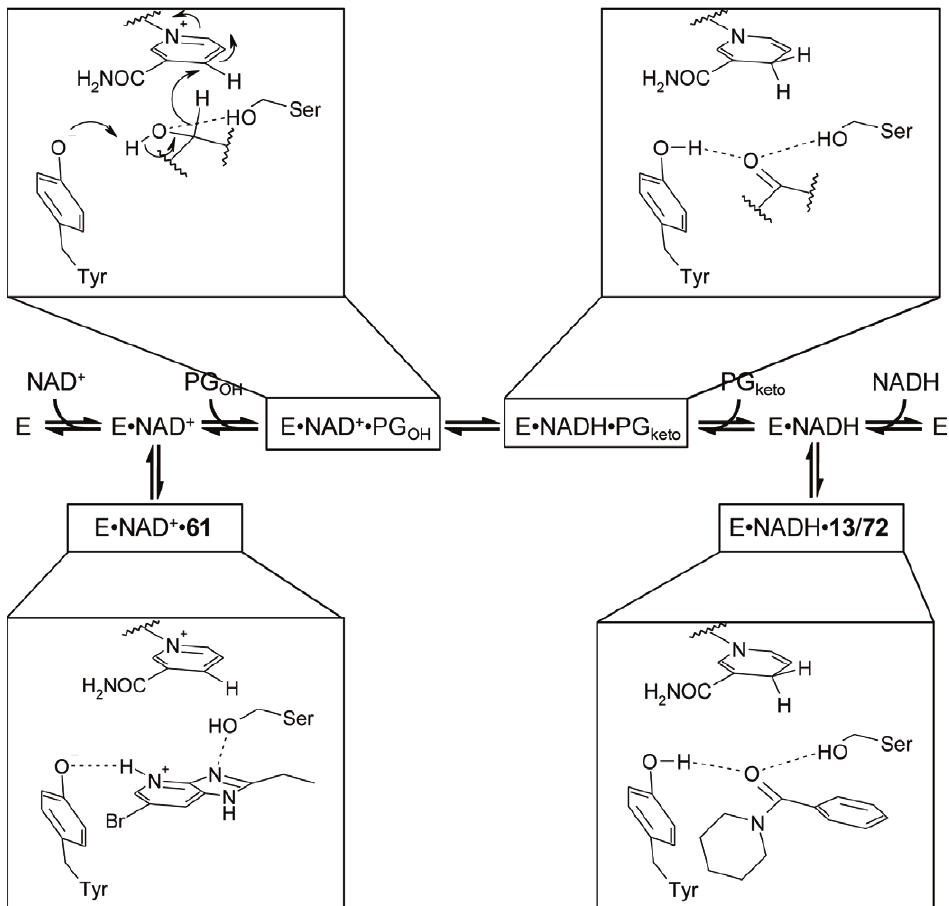
Figure 7. Proposed mechanism of prostaglandin dehydrogenation (after [ 31 ] ) and inhibitory mechanisms of action for compounds 61 and 13. Compound 61 mimics the substrate (left panels), consistent with experimental data showing favored binding to the NAD + -bound form of 15-PGDH, and its competitive mechanism of inhibition with respect to PGE 2 . Compound 13 mimics the product of oxidation (right panels), consistent with its favored binding to the NADH-bound form of 15-PGDH, and its uncompetitive mechanism of inhibition with respect to PGE 2 .